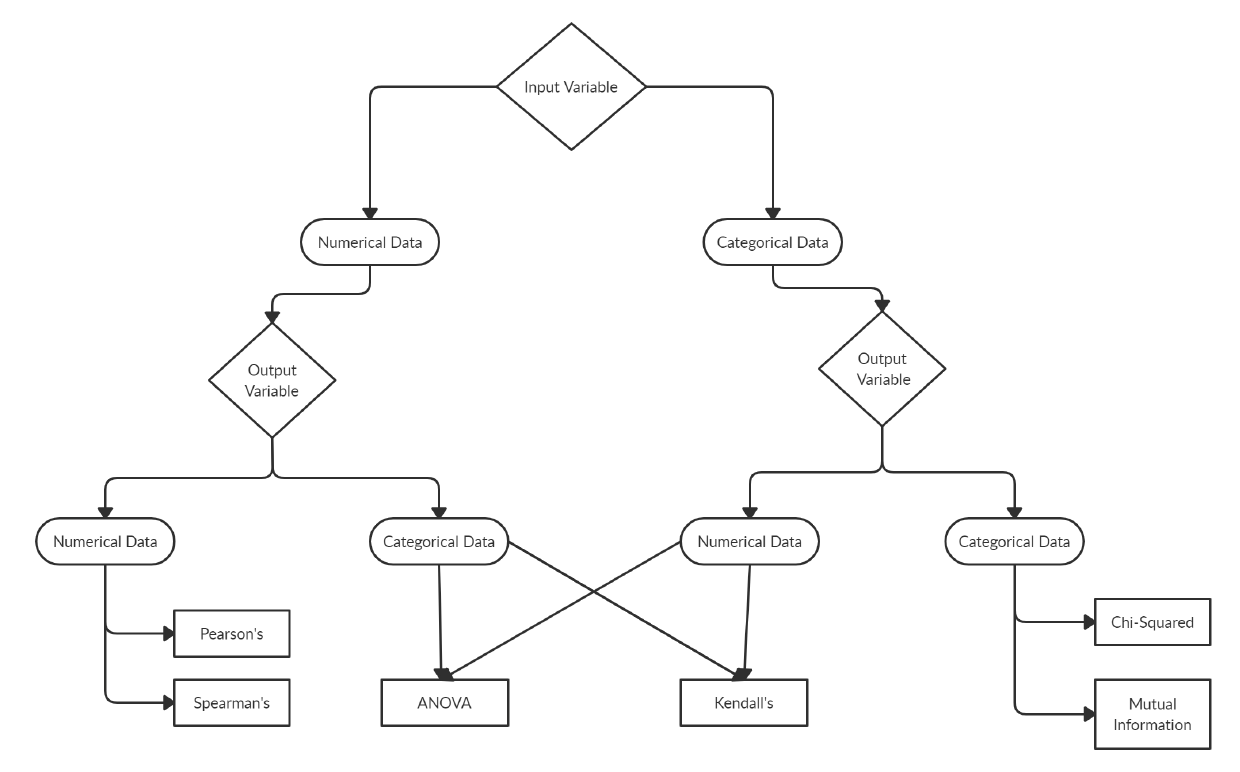
Figure 5. Types of statistical